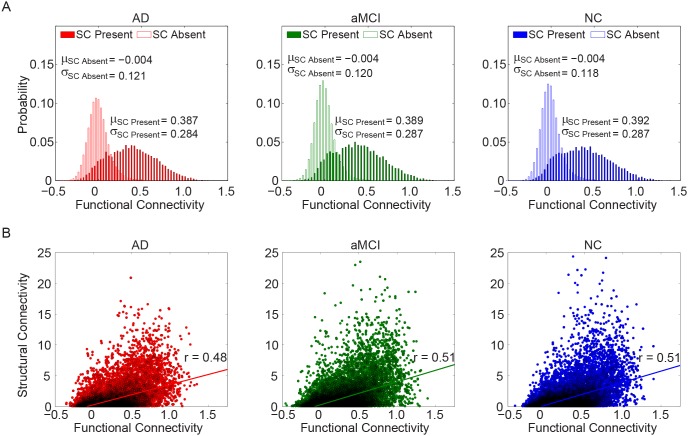
The overall FC-SC relationships.(A) The probability densities of FC strengths between structurally connected and unconnected regions pairs. When direct SC presents, higher FC strength appears than the case direct SC absents, indicating a robust relationship between FC and SC. (B) Scatter plot of SC strength against FC strength for the regions with direct SC. Further analysis showed significant coefficient between FC and SC strengths for all groups. Data are from group averaged functional connectivity matrix of AD, aMCI, and NC groups, at the high resolution (1024×1024).